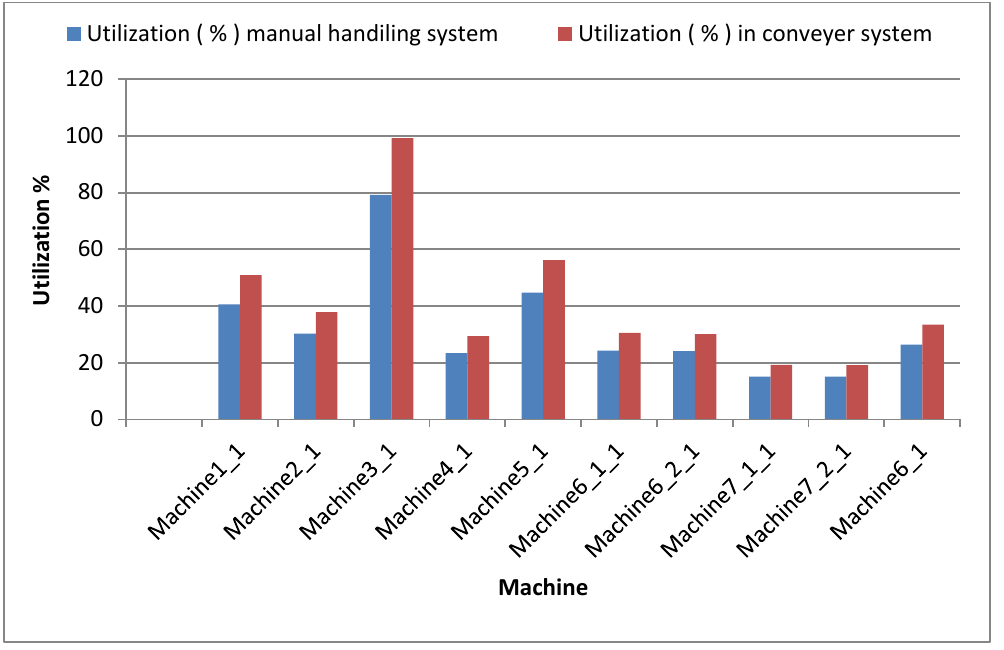
Figure 6: Comparison of utilization